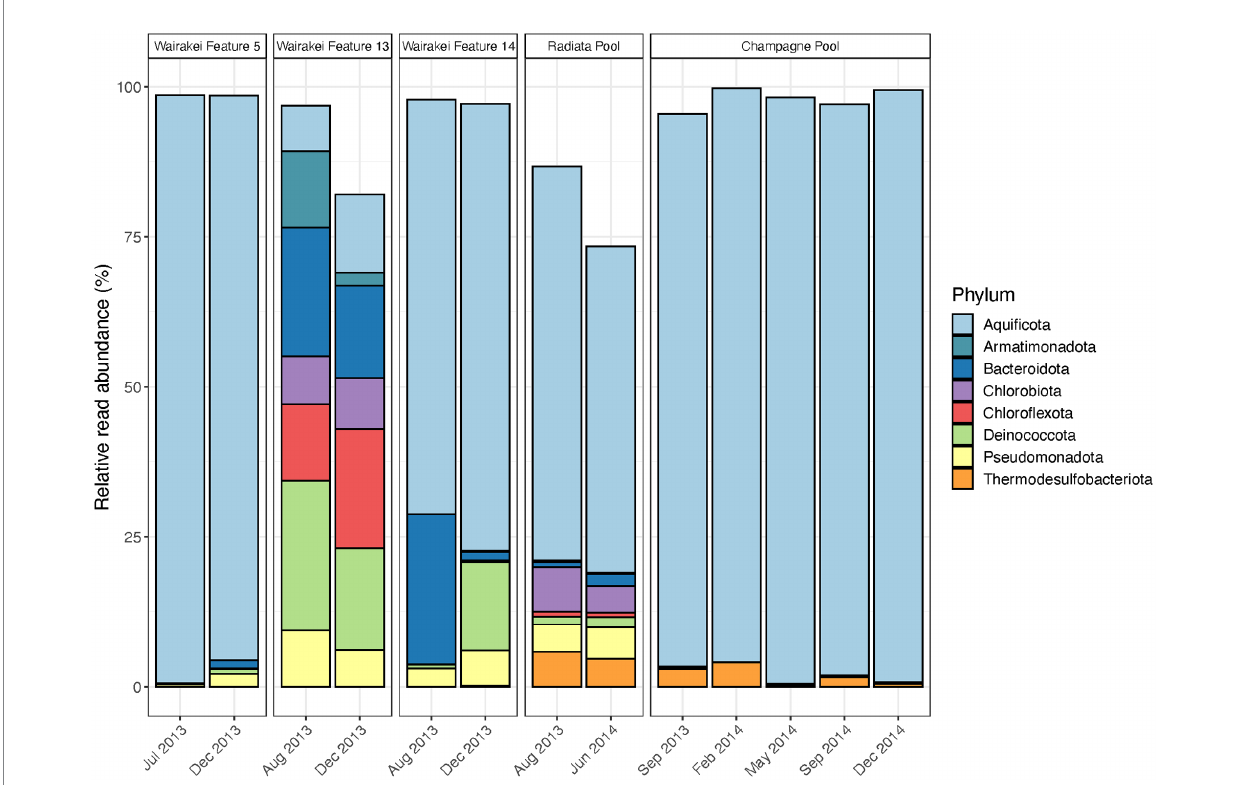
FIGURE 3 Temporal microbial community composition and relative abundance of control features in the Taupō Volcanic Zone (TVZ), Aotearoa-New Zealand. Amplicon sequencing of the 16S rRNA gene was used to measure read abundance of taxa in spring communities, with only phyla >1% average relative abundance across all samples in this category shown. Control features were sampled from the Wairakei-Tauhara (Wairakei Features 5, 13 and 14), Ngatamariki (Radiata Pool) and Waiotapu (Champagne Pool) geothermal